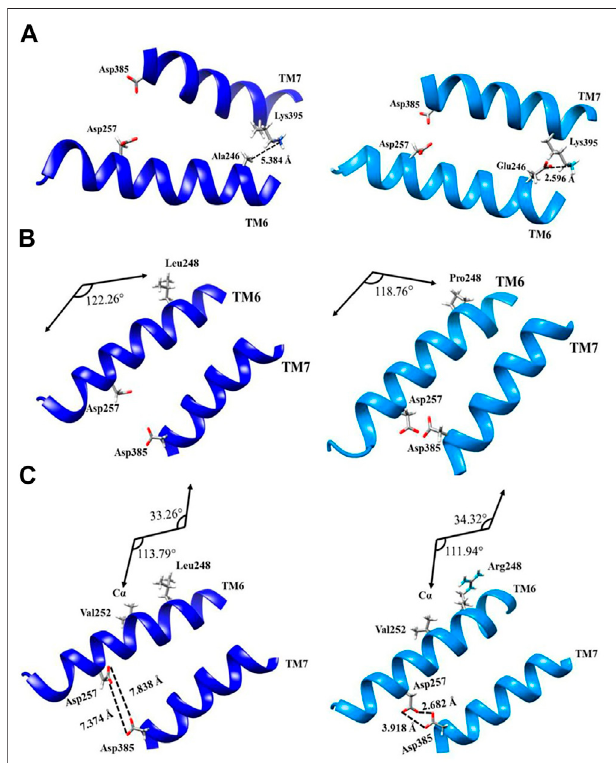
FIGURE 3 | Topological representation of structural changes of PS1 mutations Ala246Glu, Leu248Pro, and Leu248Arg: (A) ribbon representation of wild type (left, dark blue) and Ala246Glu mutation (right, light blue) from the interaction with the adjacent α -helix of the transmembrane 7; (B) ribbon representation of wild type and Leu248Pro mutation with the kink of α -helix; (C) ribbon representation of wild type and Leu248Arg mutation considering the changes in the torsional